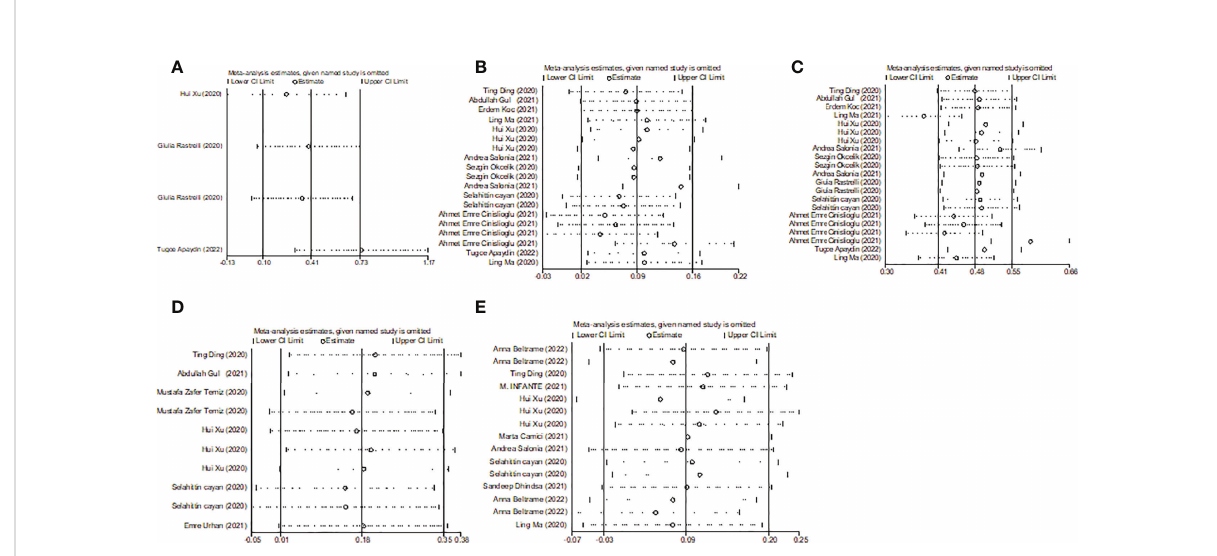
FIGURE 8 Sensitivity analyses of the WMD for (A) TT, (B) FSH, (C) LH, (D) PRL, (E) E 2 and